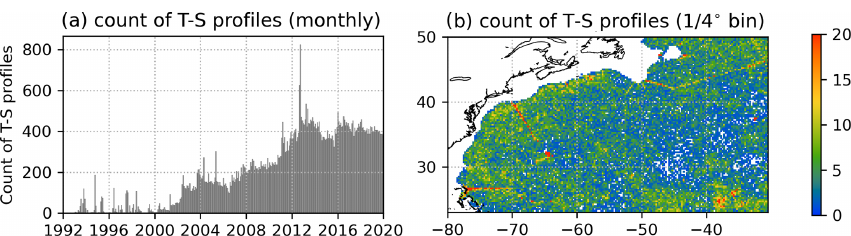
Figure 1. Count of temperature and salinity profiles extending from 25 to 1000m for the region. Profiles are counted for 1 / 4 ◦ bins (b) and represented where they exceed 0 with a truncated color bar at 20 profiles; the maximum number of profiles for a bin is 185 profiles. The count in (a) is by months. Table 1. List of input variables for the neural network and additional datasets to compare with. ESA CCI: European Space Agency Climate Change Initiative. C3S: Copernicus Climate Change Service. NOAA: National Oceanic and Atmospheric Administration. DUACS: Data Unification and Altimeter Combination System. CMEMS: Copernicus Marine Environment Monitoring